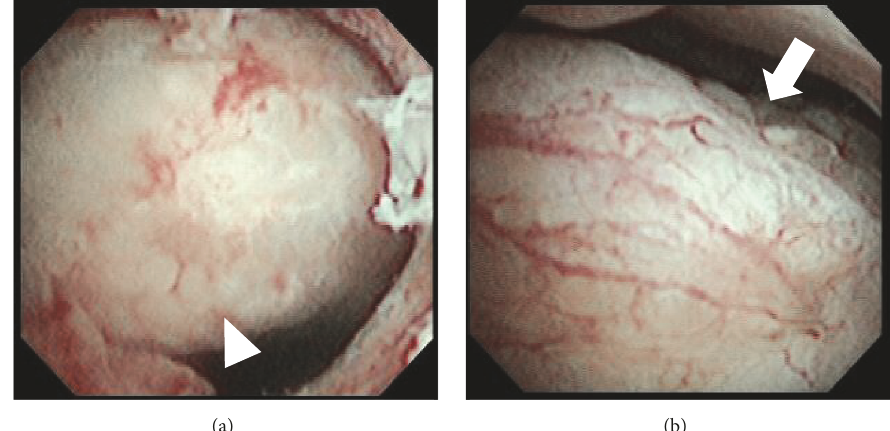
Figure 3: Hysterofiberscopy findings in this patient, showing (a) a red-yellow-white polyp with a partially reticulated surface (triangle) in the uterine cavity; (b) the lesion was easily deformed by perfusion fluid